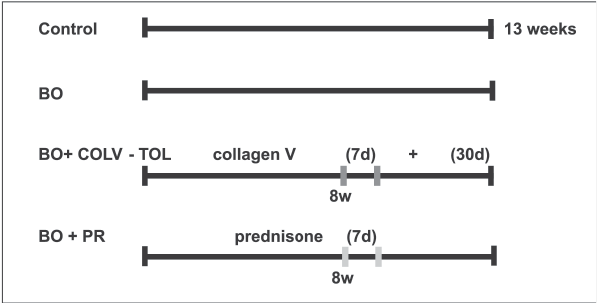
Figure 1 - Experimental Design: (i) group (CTRL): no procedures; (ii) solution instillation; bronchiolitis obliterans group (BO): single nasal HNO 3 (iii) nasal tolerance group (BO+COLV-TOL): induced after 8 weeks of bronchiolitis obliterans by daily nasal administrations of collagen V (7 days) and, subsequently, after 30 days on alternate days; (iv) bronchiolitis obliterans + prednisone group (BO+PR): after 8 weeks of bronchiolitis obliterans, treated with 0.002 mg/animal/day of prednisone for 7 days. At the end of experiments, (13 weeks), lungs were removed and histologically